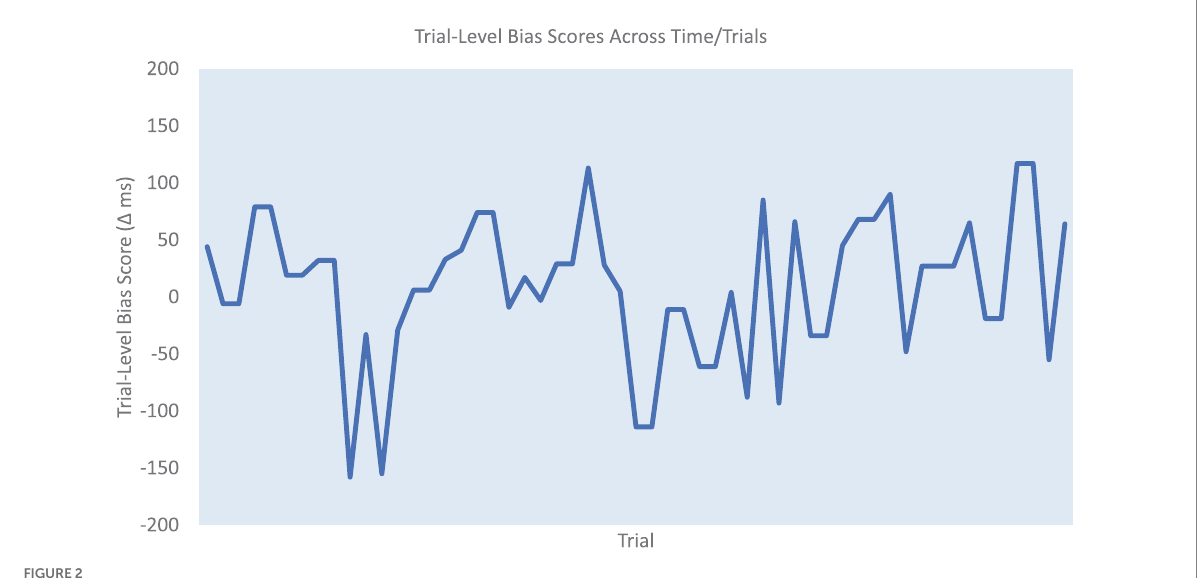
FIGURE 2 An example of trial level bias scores (TLBSs) of one block in the dot-probe task. Attention bias variability (ABV) is computed as the summed distance between succeeding TLBSs divided by the total number